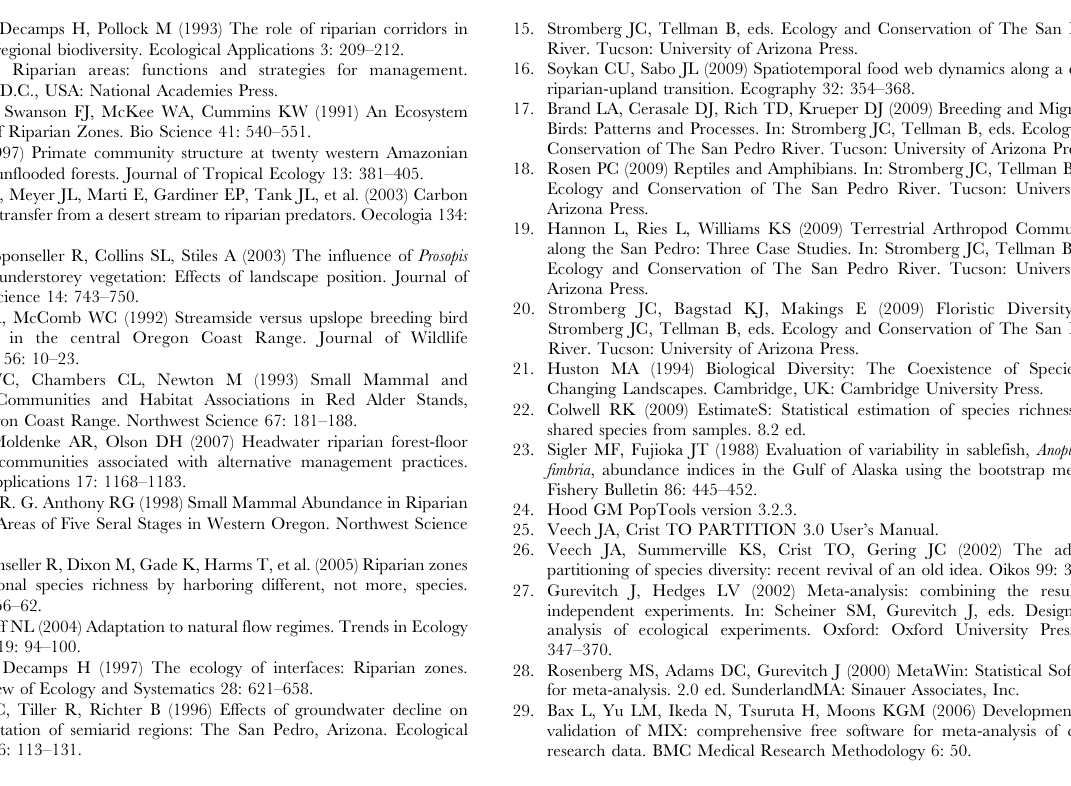
Figure S5 Taxonomy-based groupings for the riparian– upland and floodplain–river terrace (FP-RT) compari- sons. FP = river floodplain habitat type; RT = river terrace habitat type. Each point represents the unweighted effect size for a single taxonomic group belonging to one of the groupings. None of the comparisons were statistically significant at an alpha level of 0.05. Table S1 Biological groupings for the trait-level analyses. Table S2 Number of surveys/samples and number of individ- uals detected by habitat